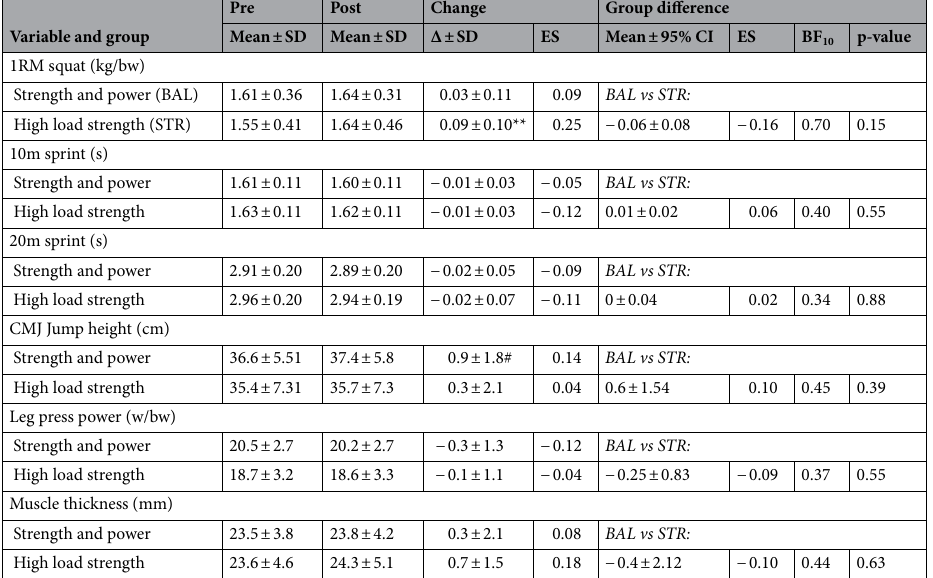
Table 3. Results from the sub-groups, strength and power training (BAL) vs high load strength program (STR). 1RM 1-repetition maximum, CMJ countermovement jump, kg kilogram, s seconds, cm centimeters,